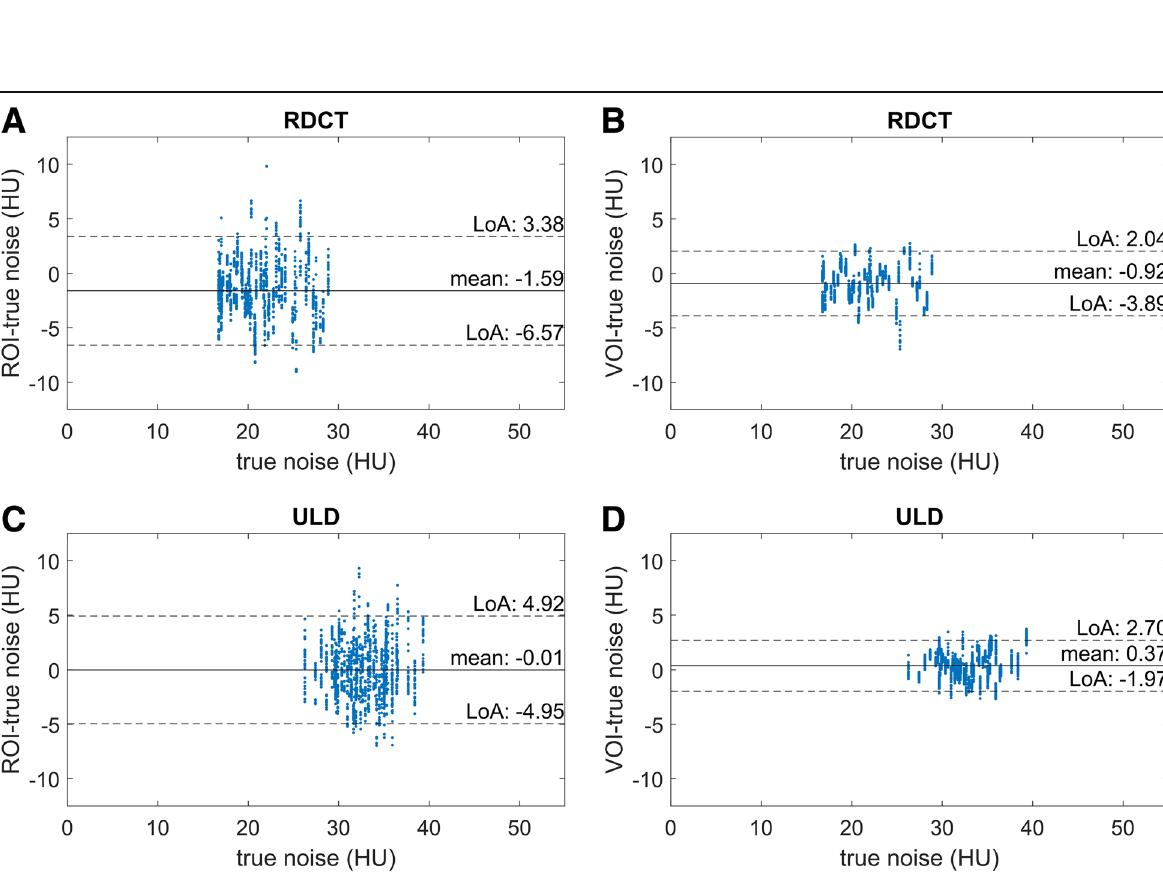
Fig. 3 Results of the Bland-Altman analyses. Each plot shows the difference between the noise measured with either ROI or VOI and ground truth noise on the y -axis, versus ground truth on the x -axis. Regular radiation dose computed tomography protocol measured with an ROI ( a ) or a VOI ( b ), same data for ultra-low dose protocol ( c and d , respectively). ROI, region of interest; VOI, volume of interest; LoA, limits of agreement; HU, Hounsfield